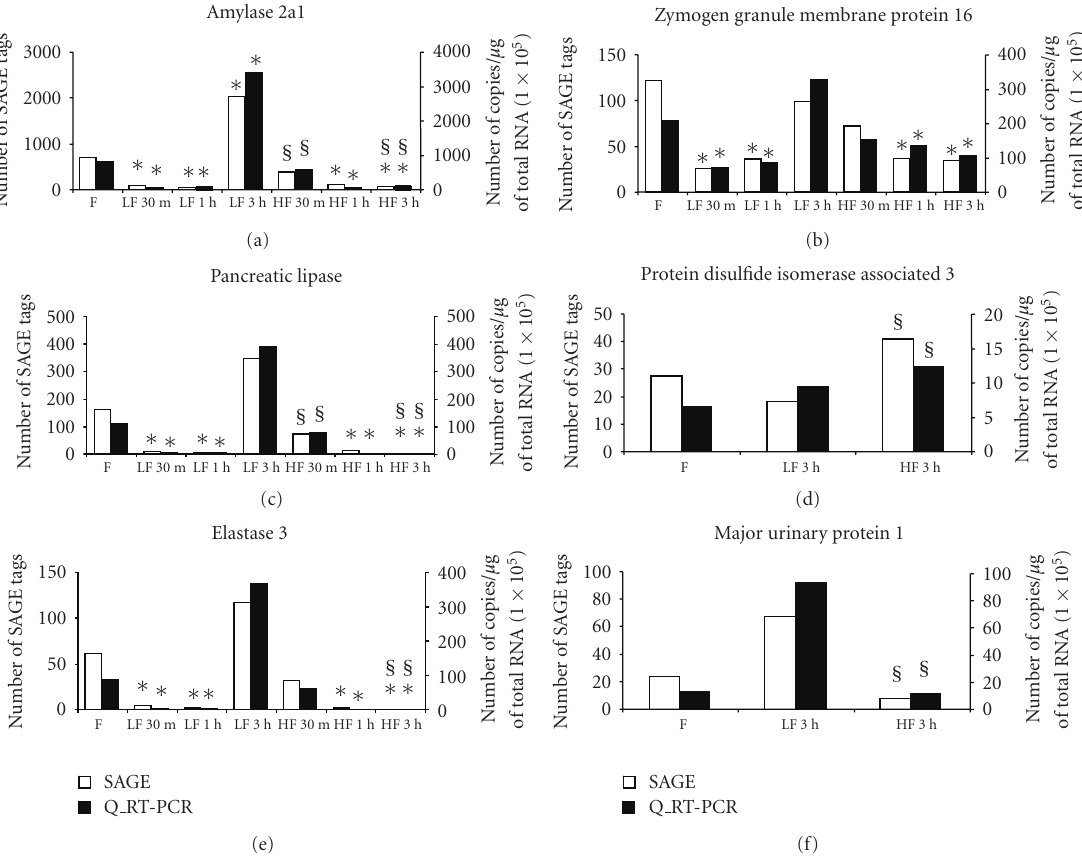
Figure 3: Serial analysis of gene expression (SAGE) and quantitative real-time PCR (Q RT-PCR) results for some representative regulated genes. ∗ Significantly di ff erent compared to fasting ( P < . 01). § Significantly di ff erent compared to low-fat (LF) meal at the same time point ( P < . 01). Abbreviations: LF, low fat; HF, high